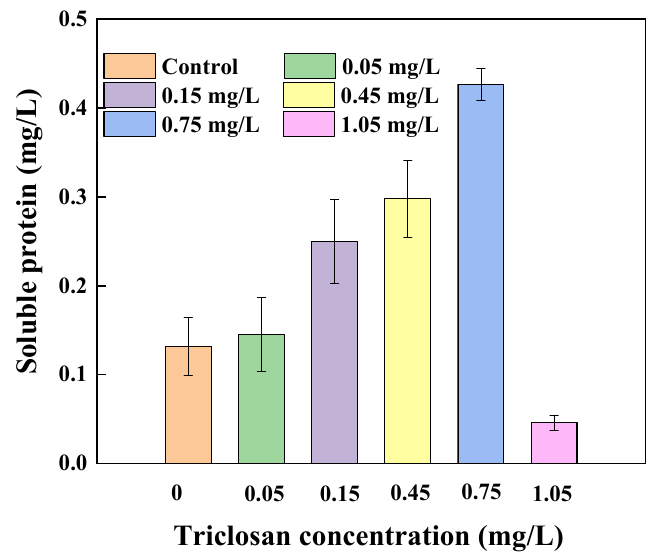
Figure 6. Effects of triclosan on the soluble protein concentration of Chlorella vulgaris .